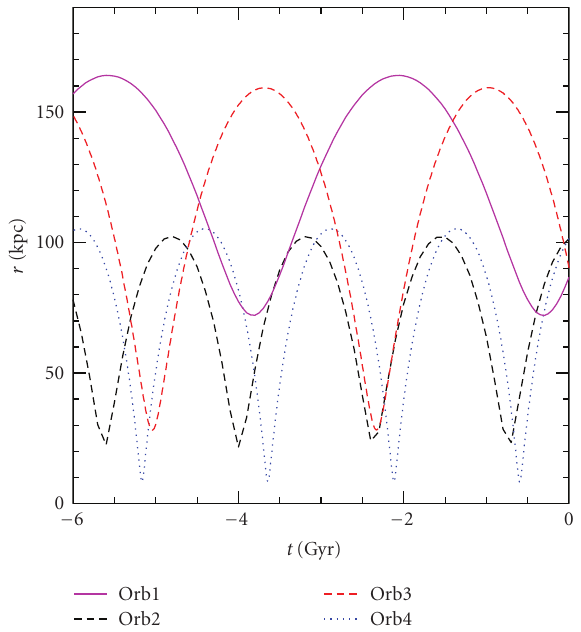
Figure 2: Galactocentric distance r as function of time for the four di ff erent orbits explored in this paper. Orbits 1 and 2 have been generated from the present-day positions and proper motions of the Sculptor and Carina dwarfs, as reported by Piatek et al. [28, 29]